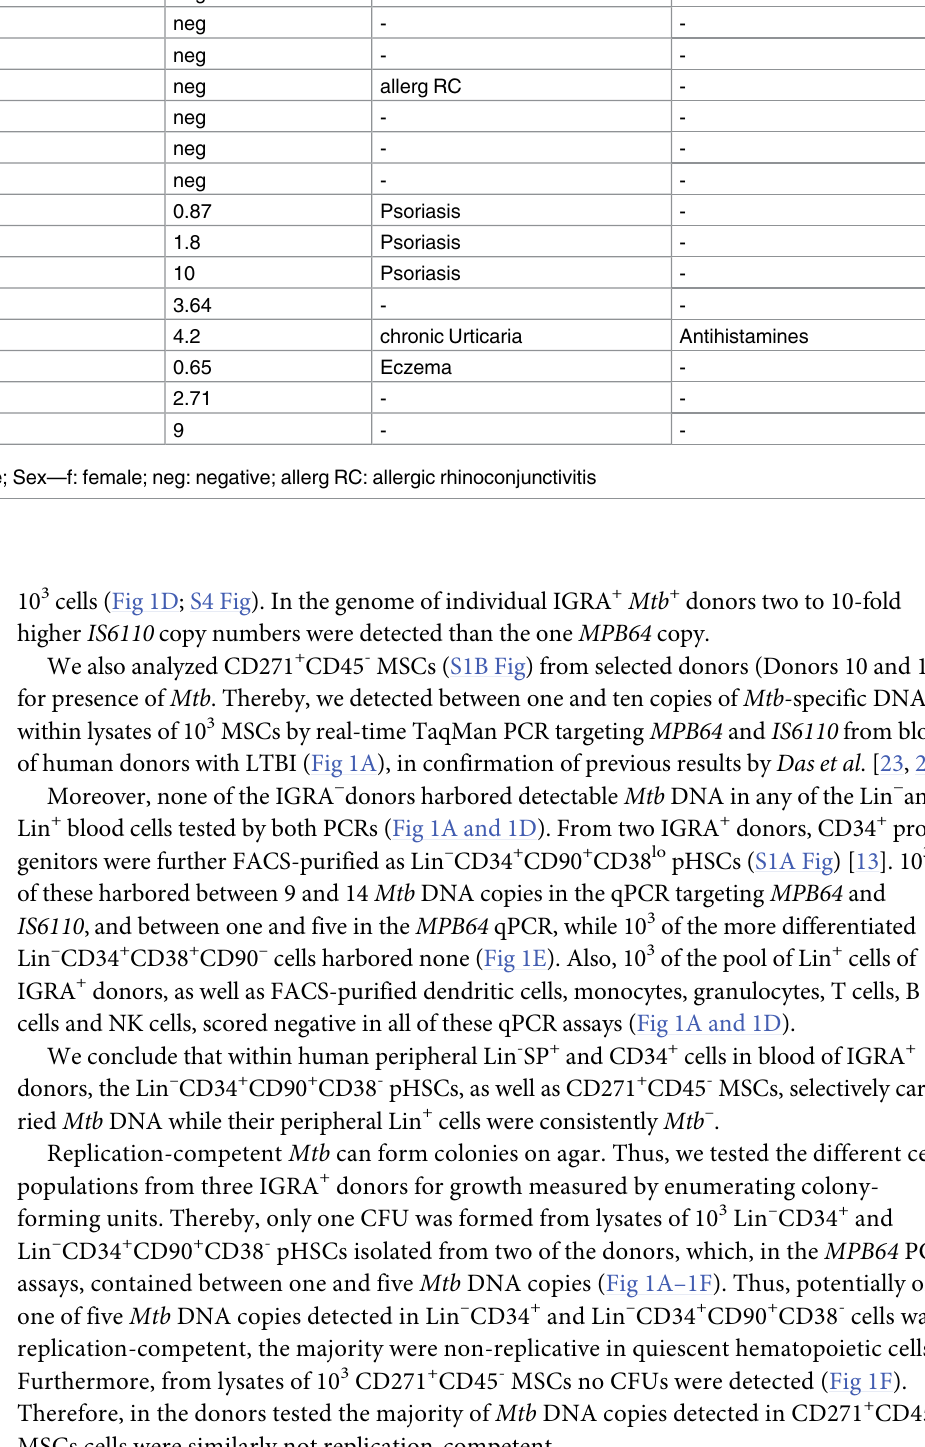
Table 1. Patient characteristics.